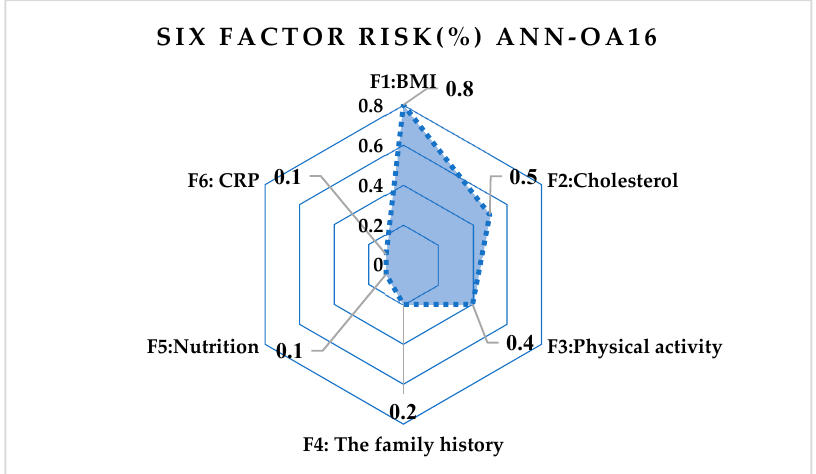
Figure 11. Influence of six risk factors on ANN-OA16.